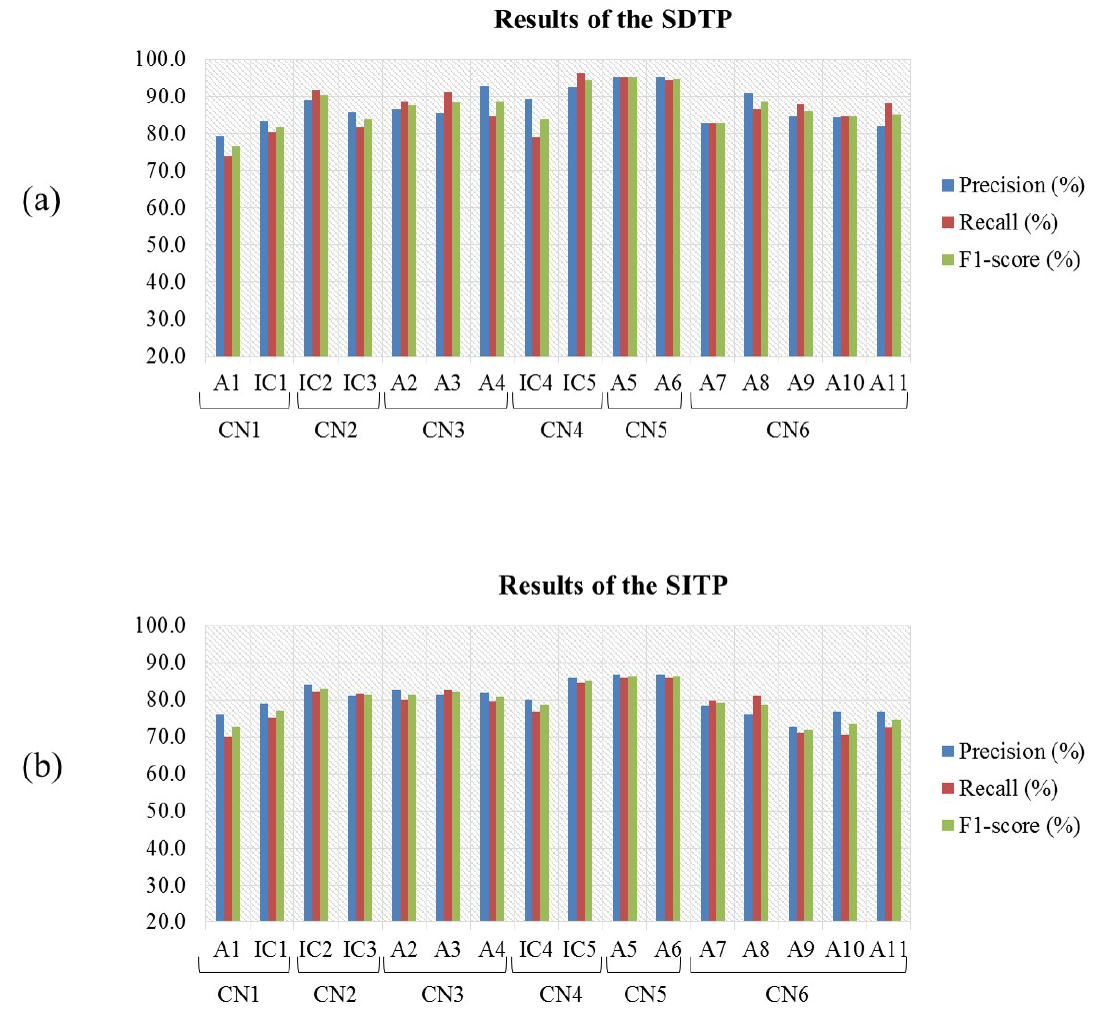
Figure 6. Average PRC, RCL, F 1 -score values of each of the eleven HMITs and the five intermediate classes for the intact subjects obtained based on the TFF of C 1 using ( a ) SDTP and ( b )